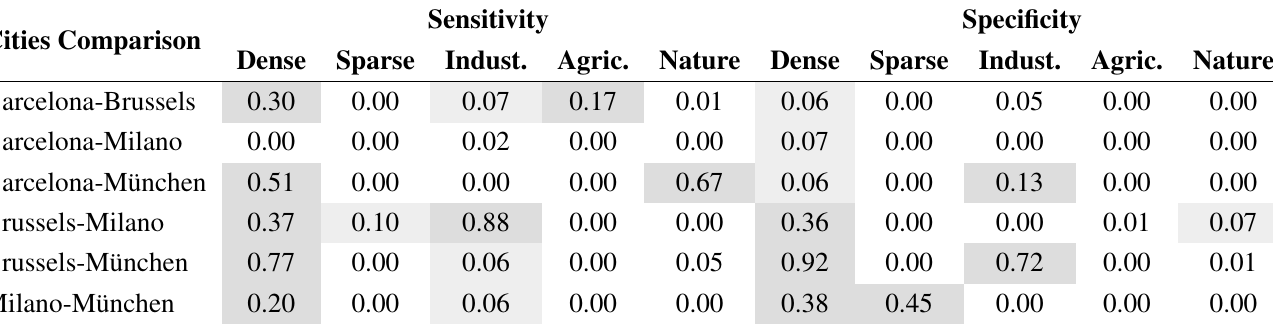
Table 7. p -values of the hypothesis tests on the difference in sensitivity and specificity between cities (“two-proportion Z-test”); five-classes classification (dense residential, sparse residential, industrial, agricultural, nature); dark gray: not significant at the 5% significance level; light gray: significant at the 10%, but not at the 5% significance